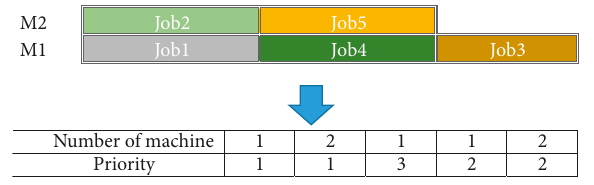
Figure 1: Illustration of solution